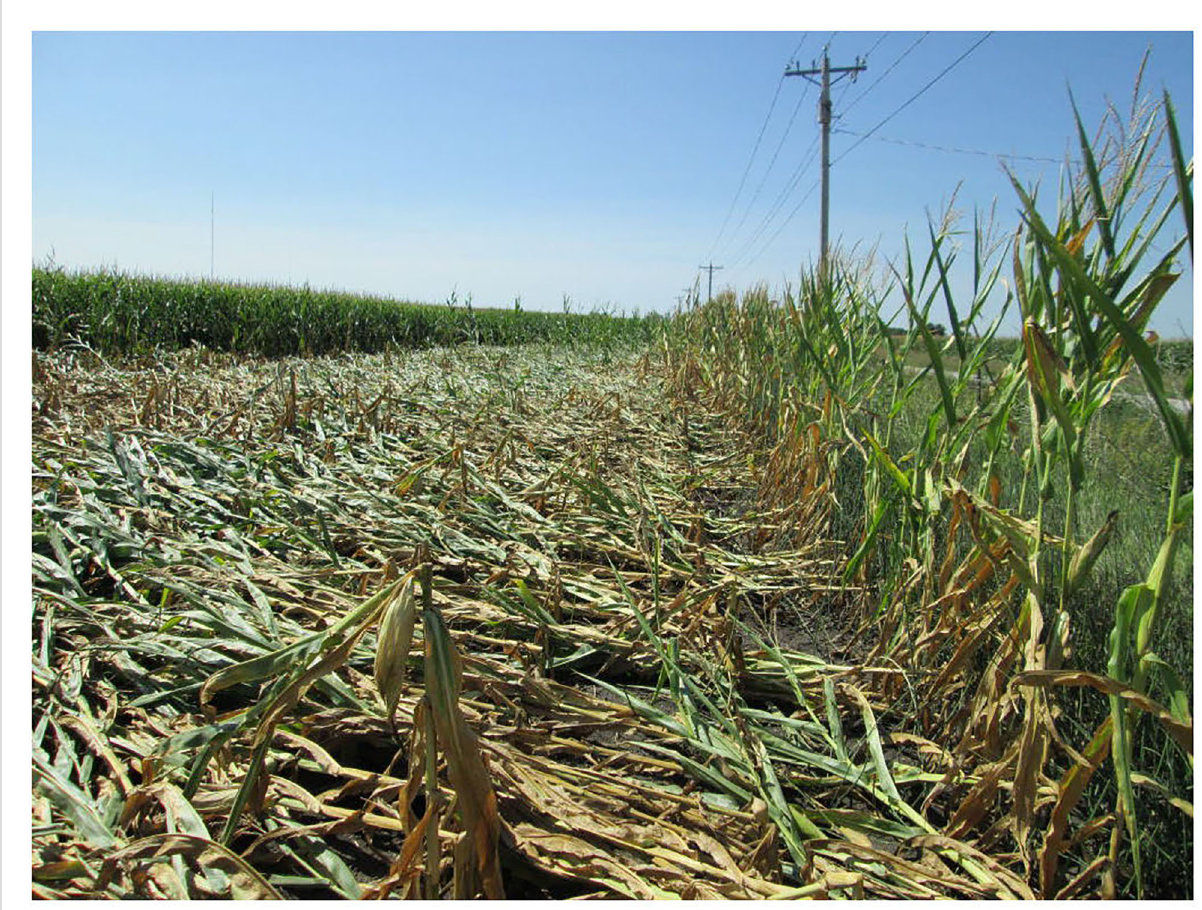
FIGURE 1 Wind damage to 16 border maize rows lacking humic product application in an upland area of a production fi eld at a reproductive growth stage, 2012. The wind direction was from right to left. The fi rst standing maize row (left) was the fi rst row that had received the humic